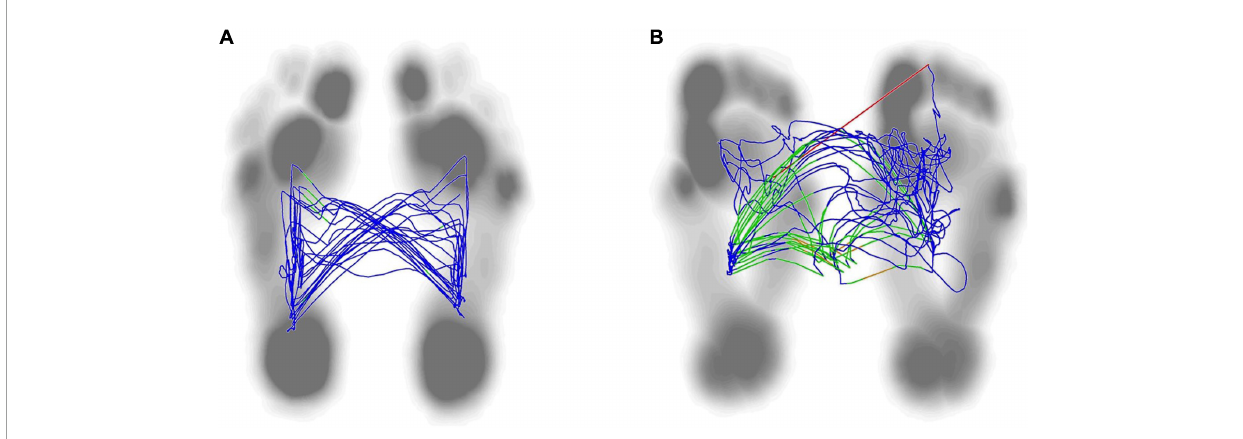
FIGURE5 Lateral symmetry of center of plantar in both group. The normal center pressure trajectories distributed in a butterfly shape, with left-right symmetry (A) . The center pressure trajectory distribution of stroke patient was asymmetrical and shifting toward the hemiplegic side (B) .